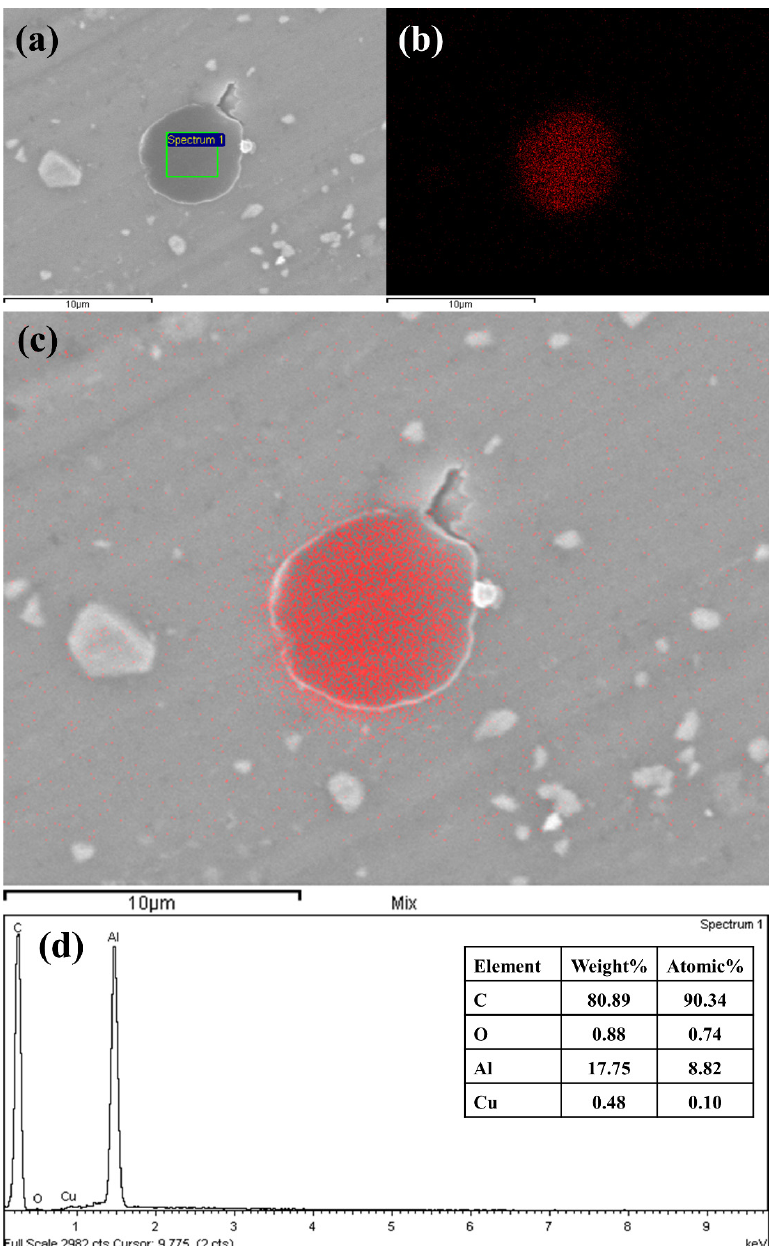
Figure 14. SEM image and elemental mapping for the surfaces tested with 0.30 vol.% nanolubricant at 20 N ( a ) and its material composition, using EDX ( b – d ).